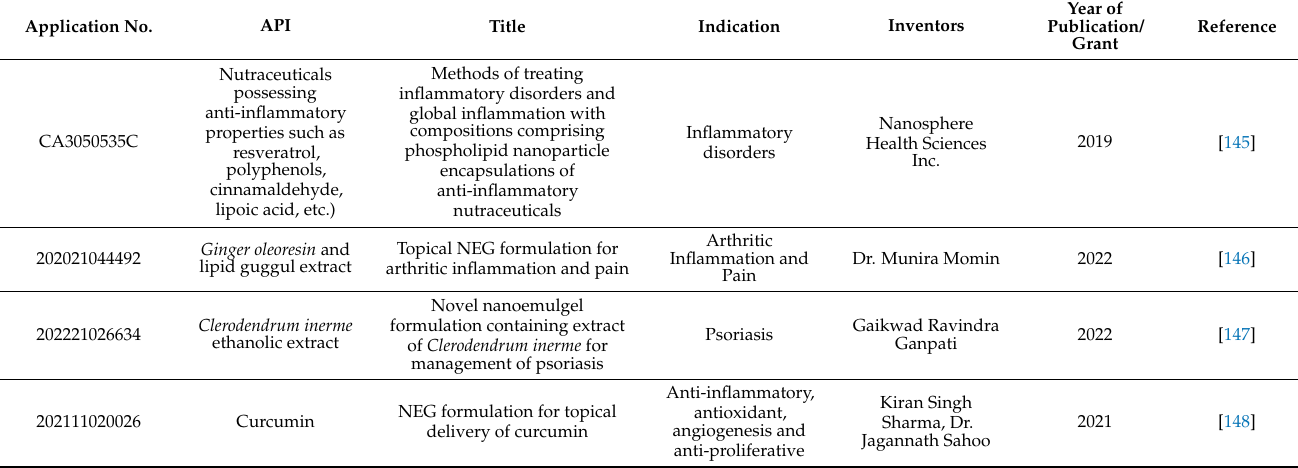
Table 4. Recent patents on nanoemulgels, specific to inflammatory